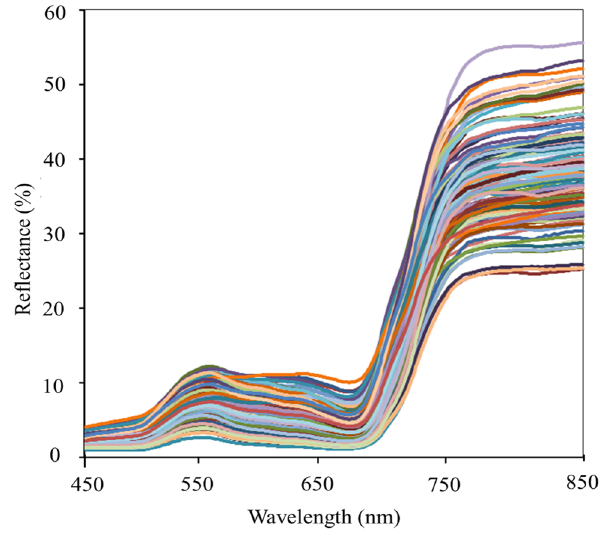
Figure 4. The measured spectra of rice plants between 450 nm and 850 nm.